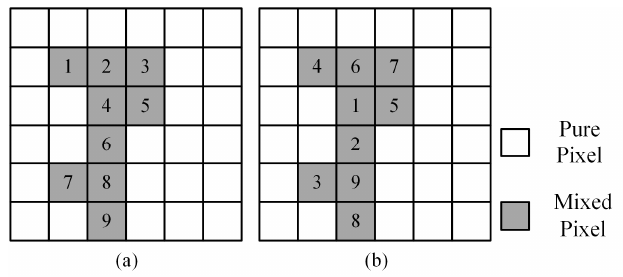
ff erent mixed pixel selection methods: ( a ) Sequential and ( b ) Figure 4. Different mixed pixel selection methods: ( a ) Sequential and ( b ) Stochastic. Figure 4. Di